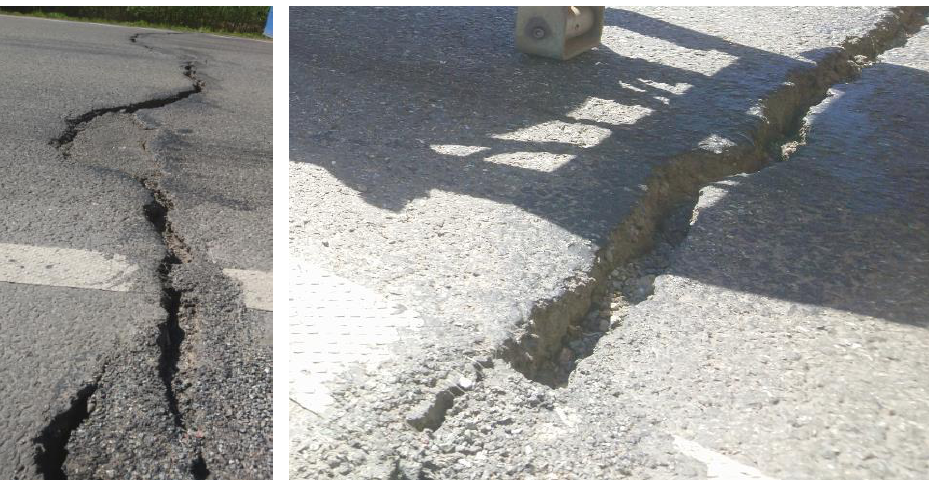
Figure 7. Examples of pavement damage caused by mining at km 1 + 216.